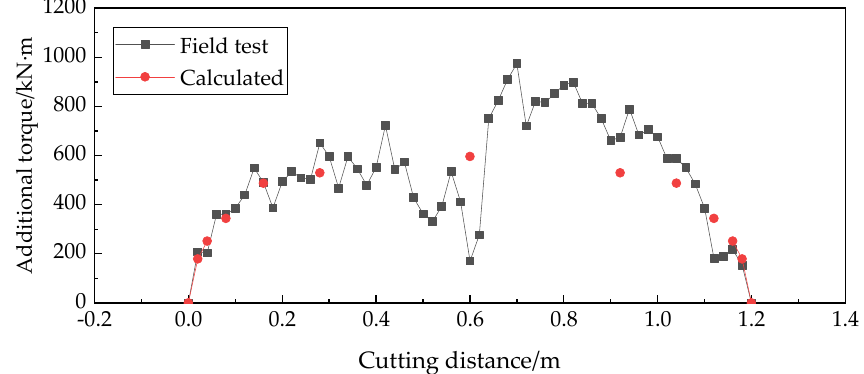
Figure 14. Additional torque at different cutting distances (pile No.1, e = 0.2 D).